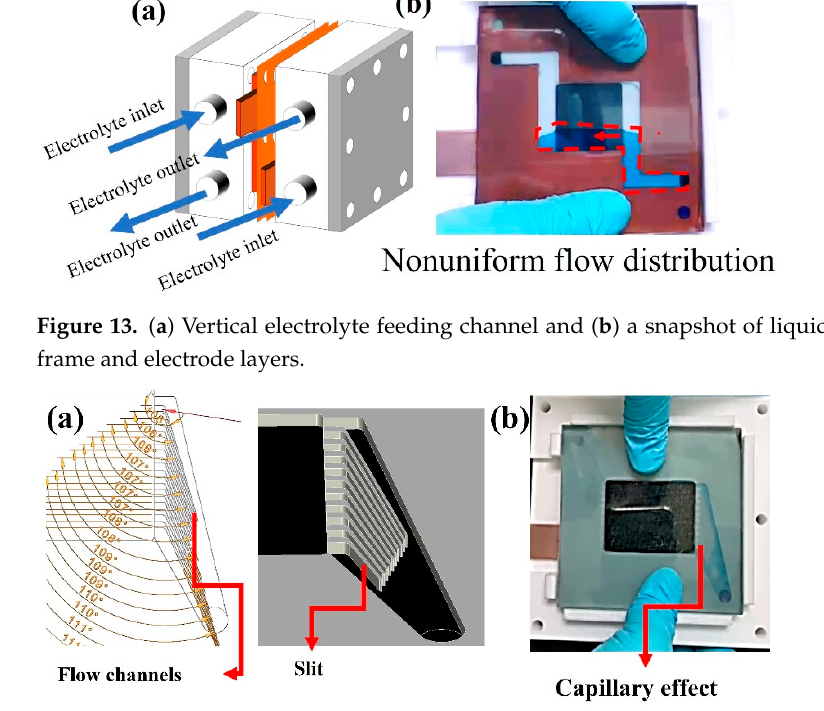
Figure 13. ( a ) Vertical electrolyte feeding channel and ( b ) a snapshot of liquid flow into the flow frame and electrode layers. Figure 14. ( a ) the schematic of cone flow channels and ( b ) electrolyte flow into the flow frame with flow channels.